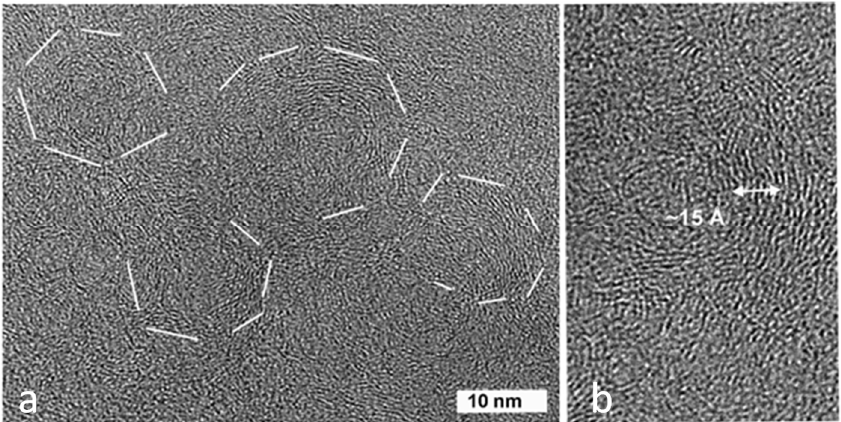
Figure 4. TEM images of the SWCNT analyzed sample with scale bar 10 nm ( a ) whereas ( b ) reports a magnification detail highlighting the bent and irregular C lattice fringes.